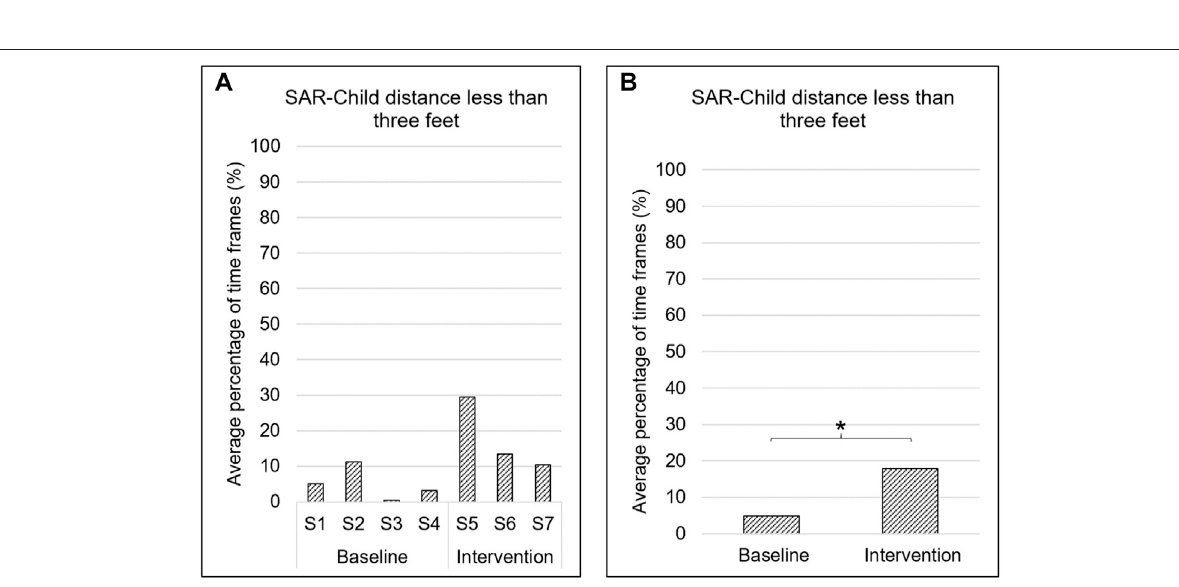
Frontiers in Robotics and AI |